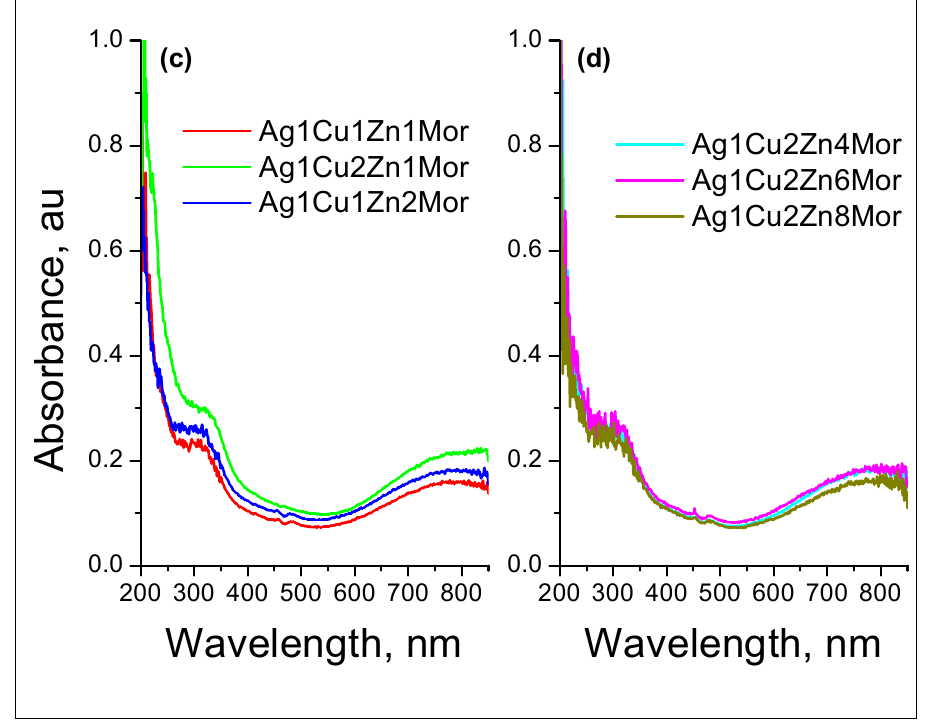
Figure 2. UV-Vis diffuse reflectance spectra of the NaMor and exchanged monometallic ( a , b ) and trimetallic ( c , d ) samples.